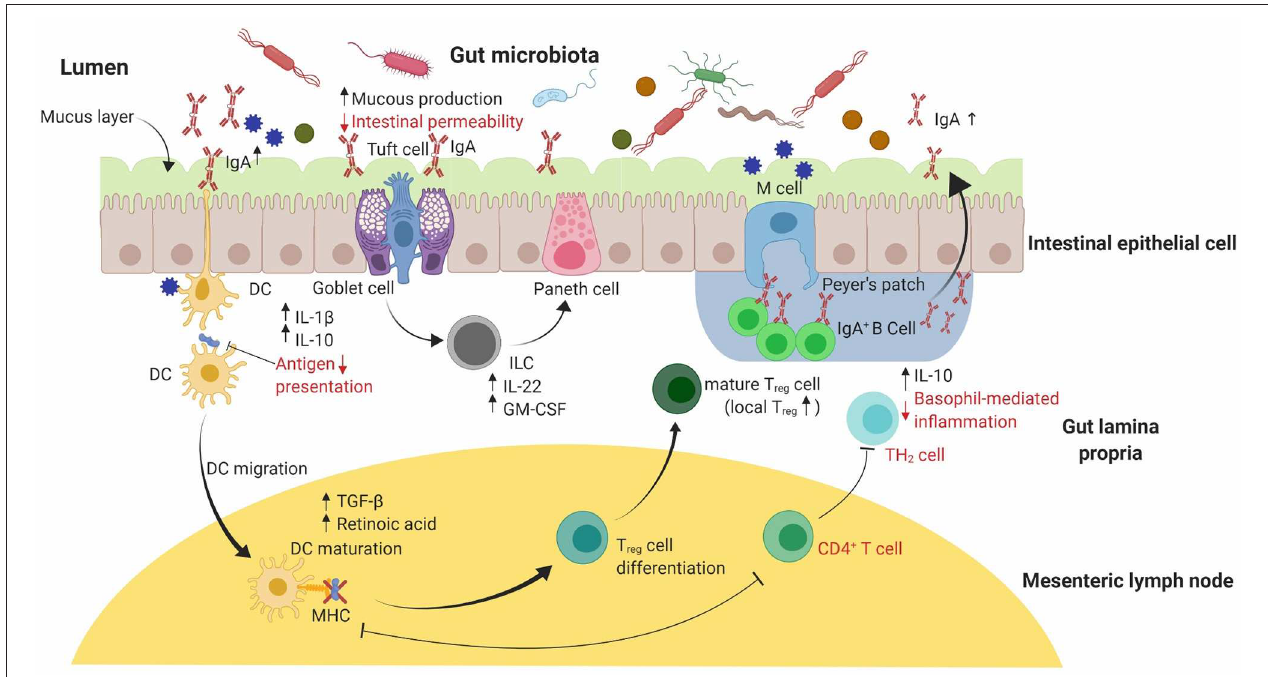
FIGURE 3 | A graphical summary of the immunomodulatory effects of probiotic supplementation on the allergic response in small animal models. An equilibrated intestinal epithelial barrier in conjunction with commensal bacteria used in probiotics have been shown to protect against allergic sensitization to food allergens. Probiotic supplementation assists in maintaining the intestinal epithelial barrier’s integrity by increasing mucus production through stimulated goblet cells. Release of IL-22 and GM-CSF by ILC cells in the lamina propria promotes mucus production and increased barrier function by stimulating Paneth cells to produce anti-microbial peptides (not shown). Reduced intestinal permeability and increased mucus production reduces the risk of food allergen translocation into systemic circulation. Probiotics can include a range of essential bacteria in the mix, thereby producing different metabolites responsible for elevated expression of Treg cells in the gut. An increase in Treg cells leads to the production of TGF- β and retinoic acid, favoring localized IgA antibody production by IgA + B-cell antibody switching in Peyer’s patches as well as increased production of IL-10 and IL-1 β . Secretory IgA antibody promote systemic tolerance to food allergens by translocating into the lumen. IL, Interleukin; GM-CSF, Granulocyte-Macrophage Colony-stimulating factor; ILC, Innate lymphoid